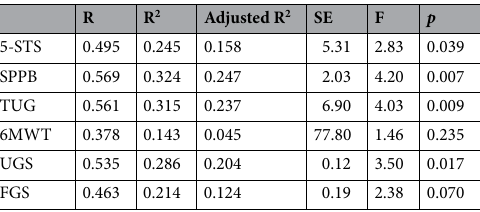
Table 2. Summary of models in women.